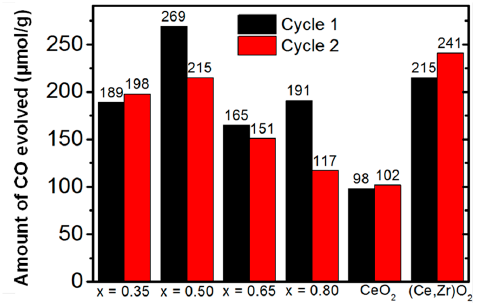
Figure 4. CO production at 1050 °C (with T red = 1400 °C) for the La 1 − x Sr x MnO 3 series and fluorite materials as referenced during two cycles [38].